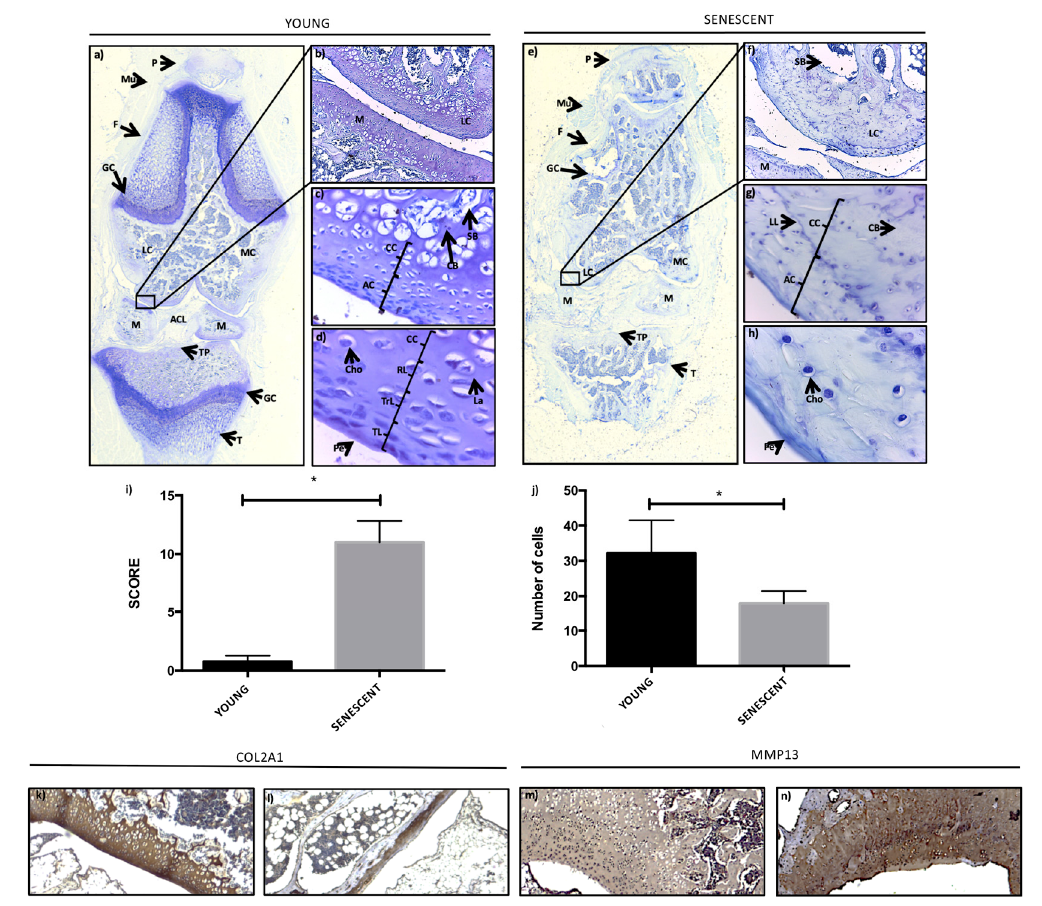
Figure 1. Histopathological comparisons of young and senescent rat knees: ( a , e ) Young and senescent rat knees, respectively. P: patella; Mu: muscle; F: femur; GC: growth cartilage; LC: lateral condyle; M: medial condyle; M: meniscus; ACL: anterior cruciate ligament; TP: tibial plateau; and T: Tibial. ( b –